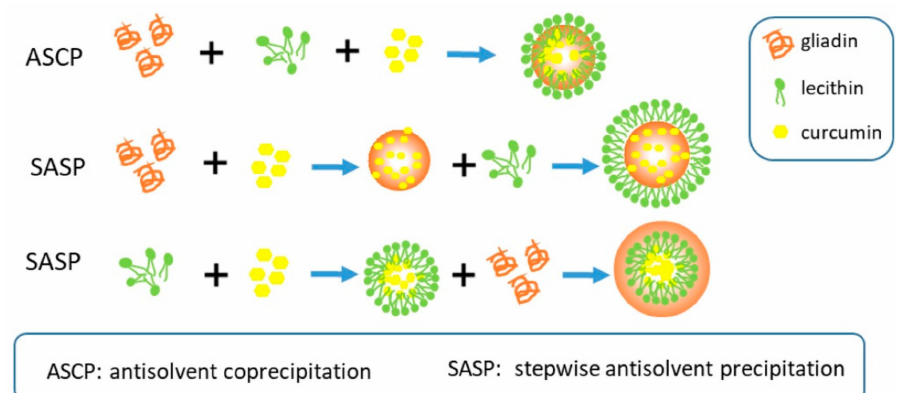
Figure 15. Schematic representation of the ASCP and SASP method of preparing lecithin-containing gliadin nanoparticles for the delivery of curcumin. Reprinted with permission from ref. [92]. Copy- right 2018